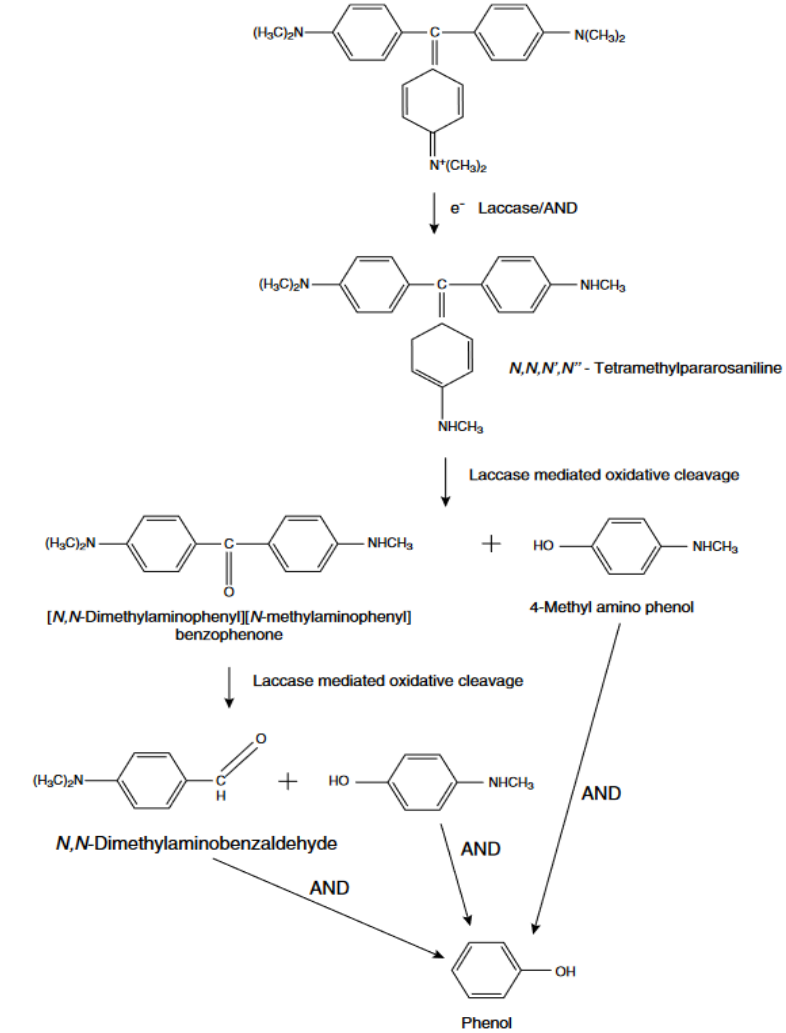
Figure 4. Mechanism of Crystal Violet degradation by